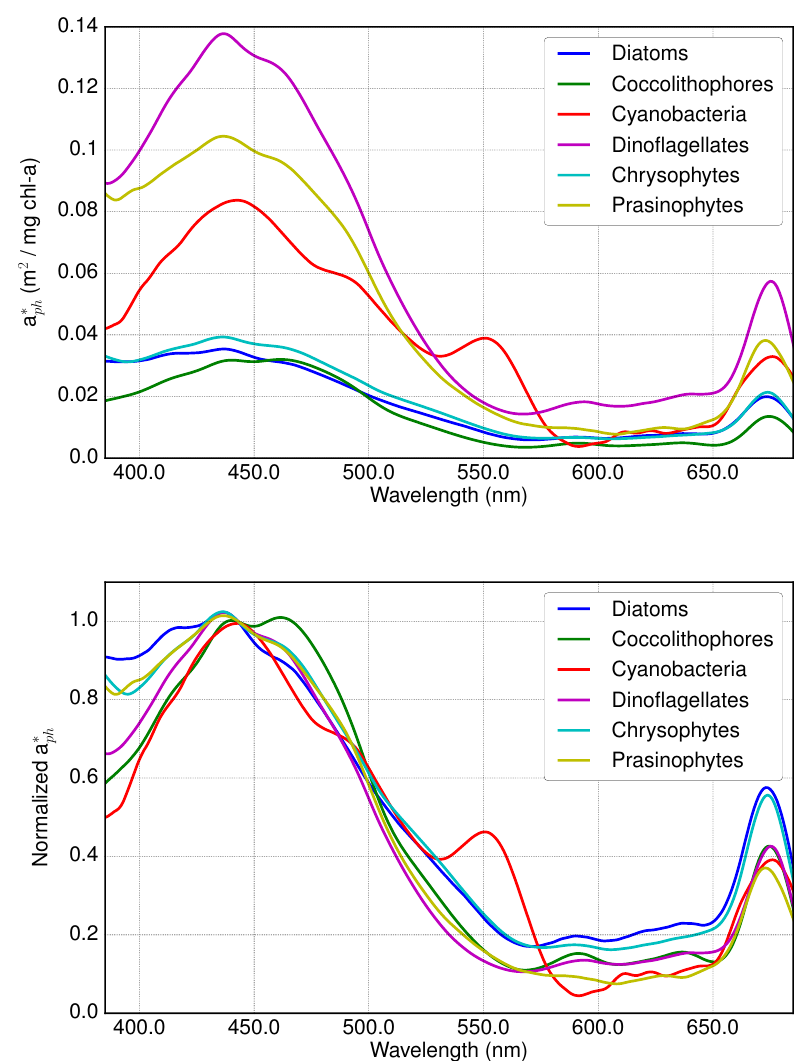
Figure 2. Measured chl-a specific (top) and normalized to 443 nm (bottom) absorption spectra ( λ ) and ¯ a ( λ ) ) of diatoms, coccolithophores, cyanobacteria, dinoflagellates, chrysophytes ( a ∗ ∗ φ φ and